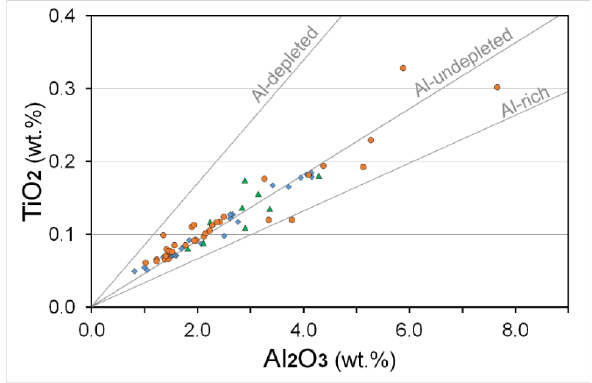
Figure 15. Plot of bulk-rock contents of Al 2 O 3 vs. TiO 2 both expressed in weight %, showing compositional variations of the Lyavaraka complex (orange symbol; this study) compared with the compositional field of the Chapesvara complex [12] (blue symbol) and the differentiated flow of the Mount Khanlauta complex [13] (green symbol). Schematic trends of the Al-depleted, Al-undepleted and Al-rich komatiites are shown for comparison, after [40].